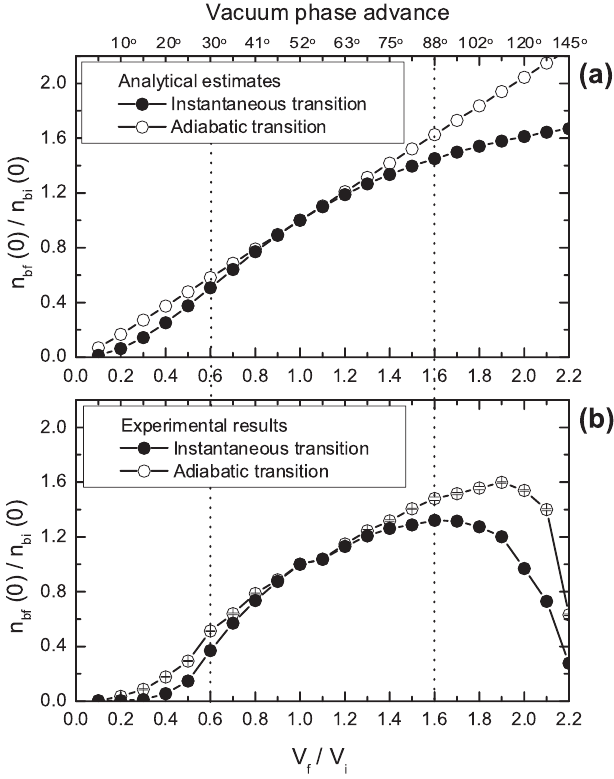
FIG. 6. Plots of the ratio of final to initial on-axis beam density (cid:5) 0 (cid:6) =n (cid:5) 0 (cid:6) for different values of V n bf bi (cid:5) 0 (cid:6) =n (cid:5) 0 (cid:6) are either (a) estimated from analytical The values n bf bi theory, or (b) measured experimentally. Here, the initial vacuum phase advance (cid:5) is 52 (cid:3) , which corresponds to (cid:5) sf vi Both instantaneous (solid circles) and adiabatic (open circles) transitions are